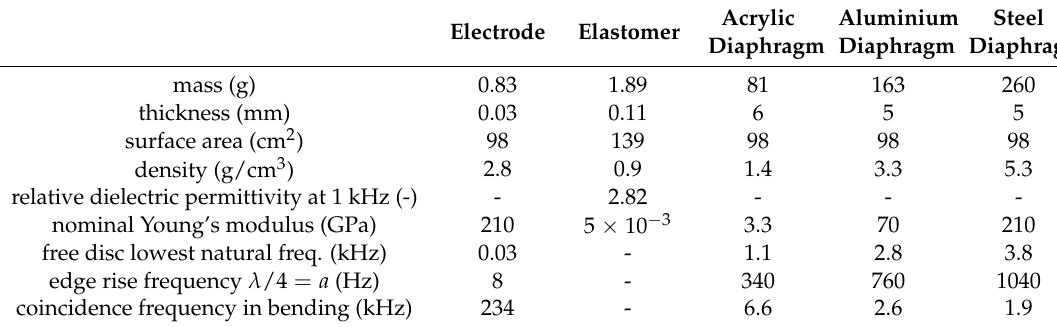
Figure 3. Experimental measurement of natural rubber Thera-Band extra thin Resistance Band physical properties: ( a ) relative dielectric permittivity; and ( b ) Young’s modulus. properties: ( a ) relative dielectric permittivity; and ( b ) Young’s modulus. Table 1. Physical properties of electrode, elastomer and diaphragm; 𝑎 is the radius of the layer and 𝜆 is the bending wavelength. Table 1. Physical properties of electrode, elastomer and diaphragm; a is the radius of the layer and λ is the bending